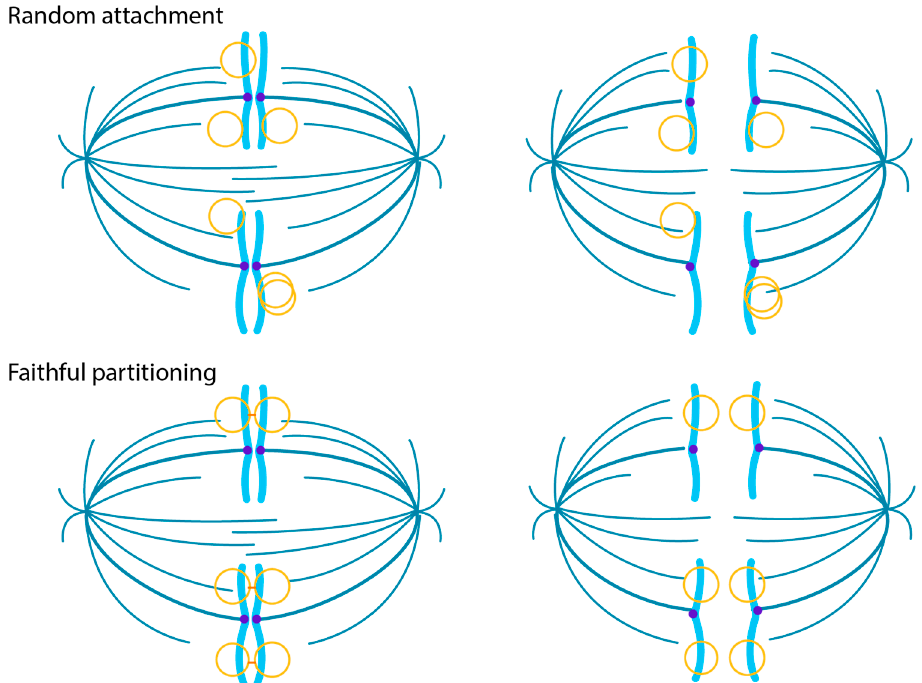
Figure 3. Models of viral genome partitioning. In the Random Attachment model, HPV genomes associate with the host chromosomes after DNA replication. In the Faithful Partitioning Model, the viral genomes are attached to the host chromatin throughout the cell cycle. Each daughter molecule is faithfully distributed to a daughter cell. Shown are viral DNA (yellow), host DNA (cyan), cohesin (orange), and the spindle